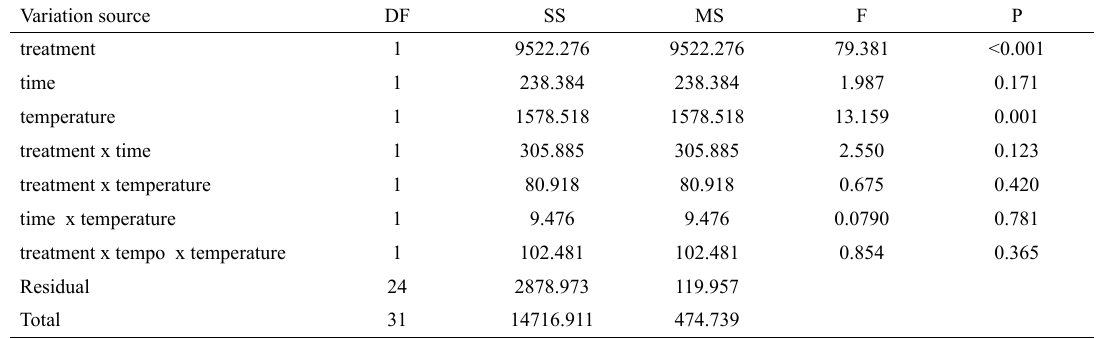
Table 3. ANOVA results (three-way)